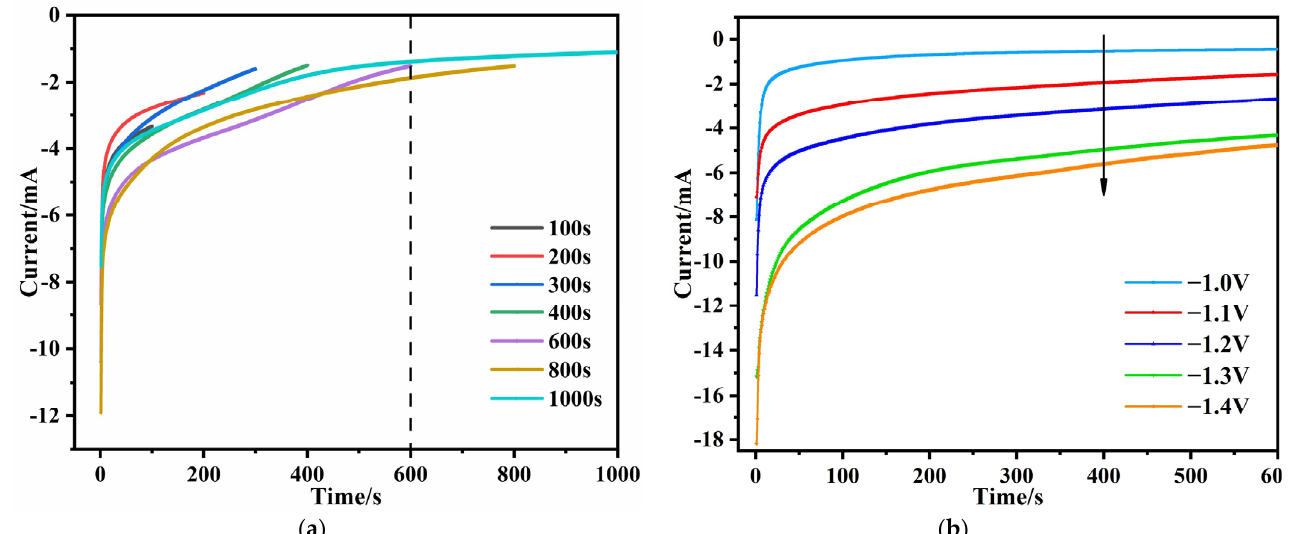
Figure 2. ( a ) Current-time response curves for the process of depositing silica films on Cu at different times at − 1.2 V vs. Ag/AgCl. ( b ) Current-time response curves for the deposition of silica films at different voltages (scan rate: 1 mV/s).